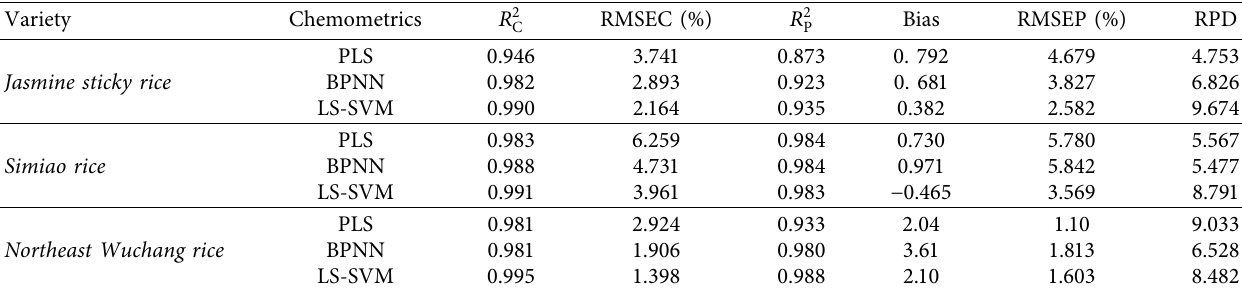
Table 3: Performance of PLS, LS-SVM, and BPNN models for predicting adulteration proportion in Thai jasmine rice (%). Variety